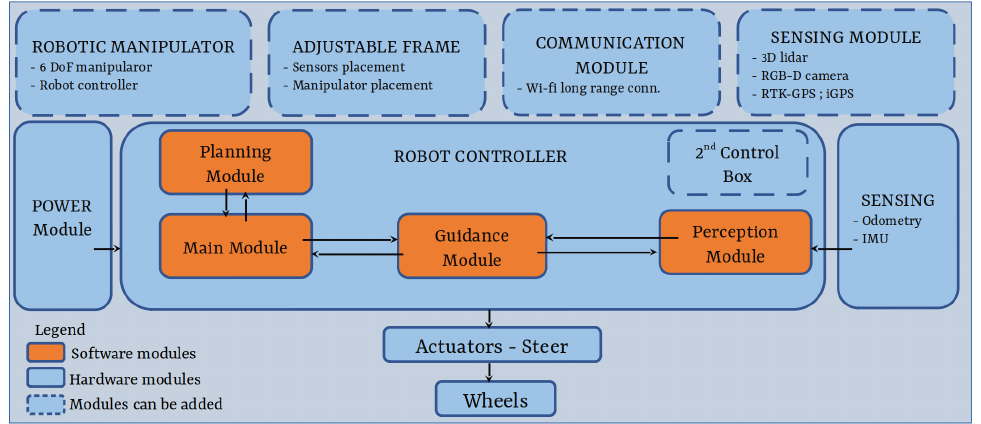
Figure 1. Functional architecture of the reconfigurable mobile platform. The main SW modules are depicted in orange. Arrows represent the main flow of information and the communication between